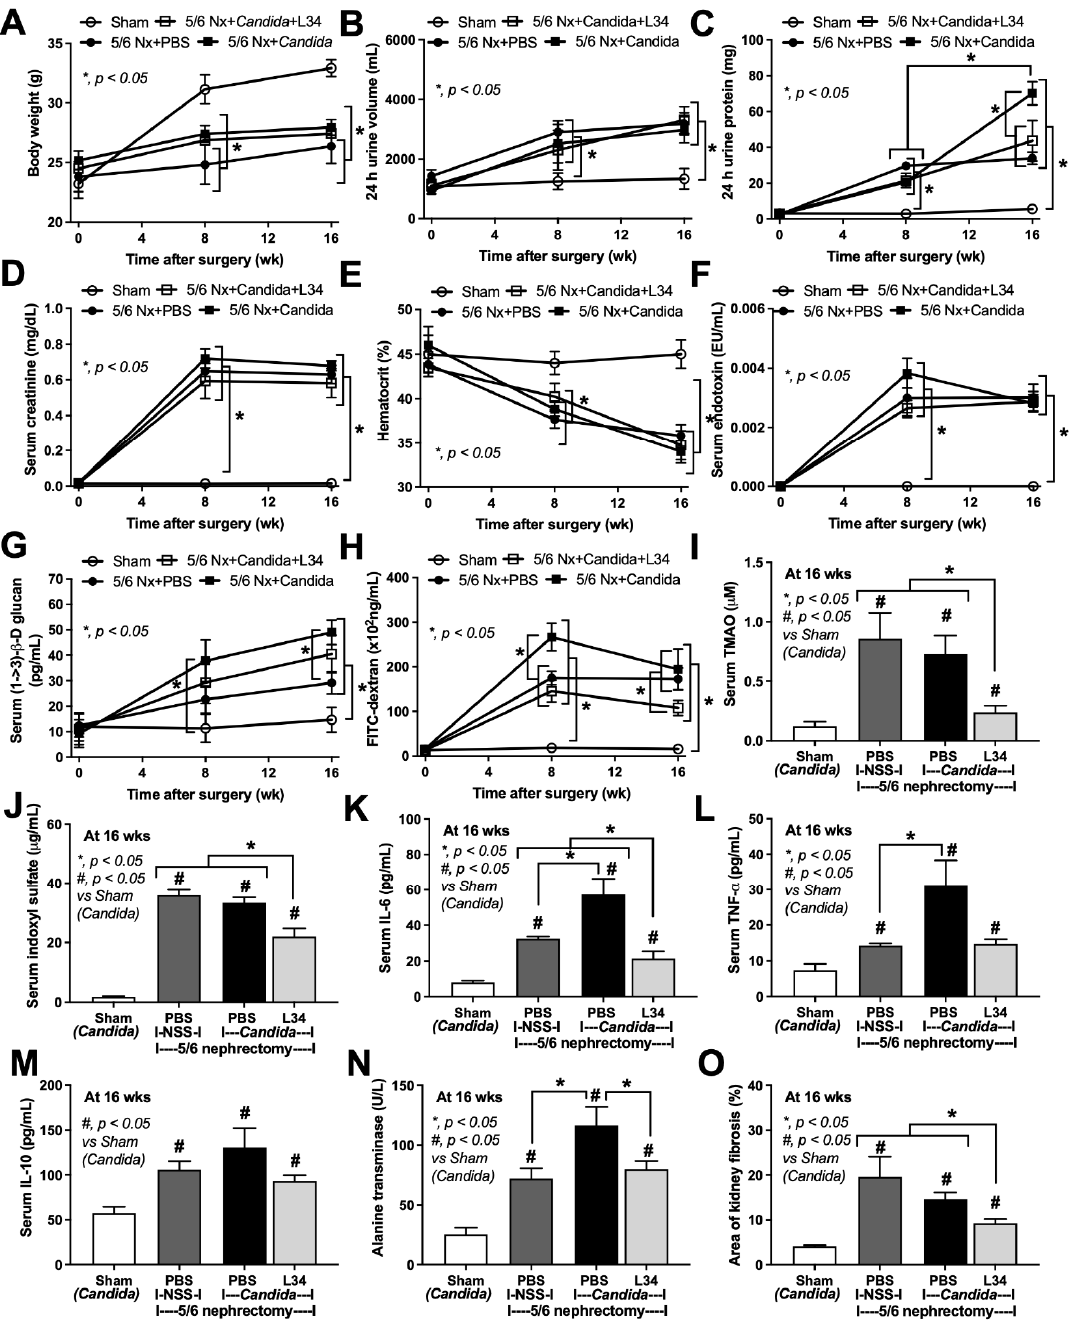
Figure 1. The characteristics of Sham control, 5/6 nephrectomy mice with phosphate buffer solution (5/6 Nx + PBS), Candida -administered 5/6 nephrectomy mice with Lacticaseibacillus rhamnosus L34 (5/6 Nx + Candida + L34) or without the probiotics (5/6 Nx + Candida ) as indicated by the time-point of: ( A ) body weight; ( B ) 24-h urine volume; ( C ) 24-h urine protein; ( D ) serum creatinine; ( E ) hematocrit, and gut barrier defect: ( F ) endotoxemia; ( G ) serum (1 → 3)- β -D-glucan; and ( H ) FITC-dextran; with the parameters at 16 weeks of the model, including serum gut-derived uremic toxins: ( I ) Trimethylamine N-oxide (TMAO) and ( J ) indoxyl sulfate; serum cytokines: ( K ) IL-6; ( L ) TNF- α ; and ( M ) IL-10; ( N ) liver enzyme (alanine transaminase); and ( O ) renal fibrosis score are demonstrated (n = 6–10/time-point or